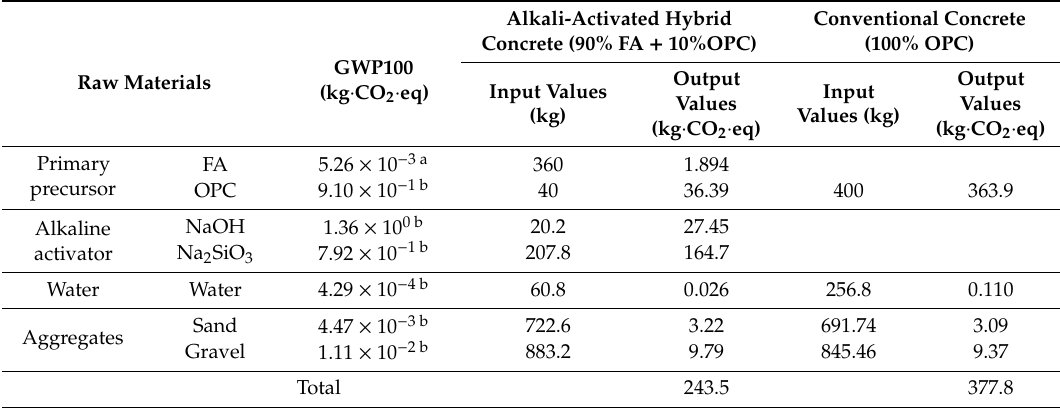
Table 8. Inventory of emissions and impacts associated with raw materials of alkali-activated hybrid